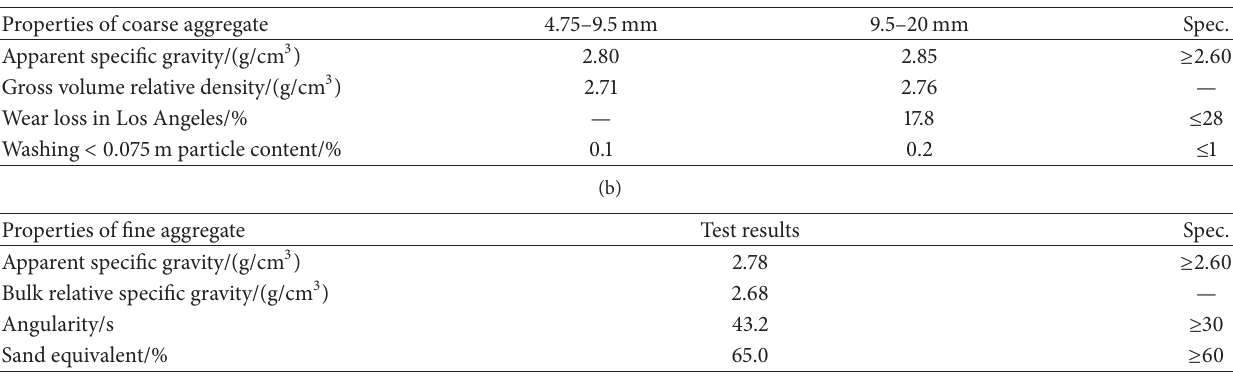
Table 4: Properties of coarse and fine aggregates.